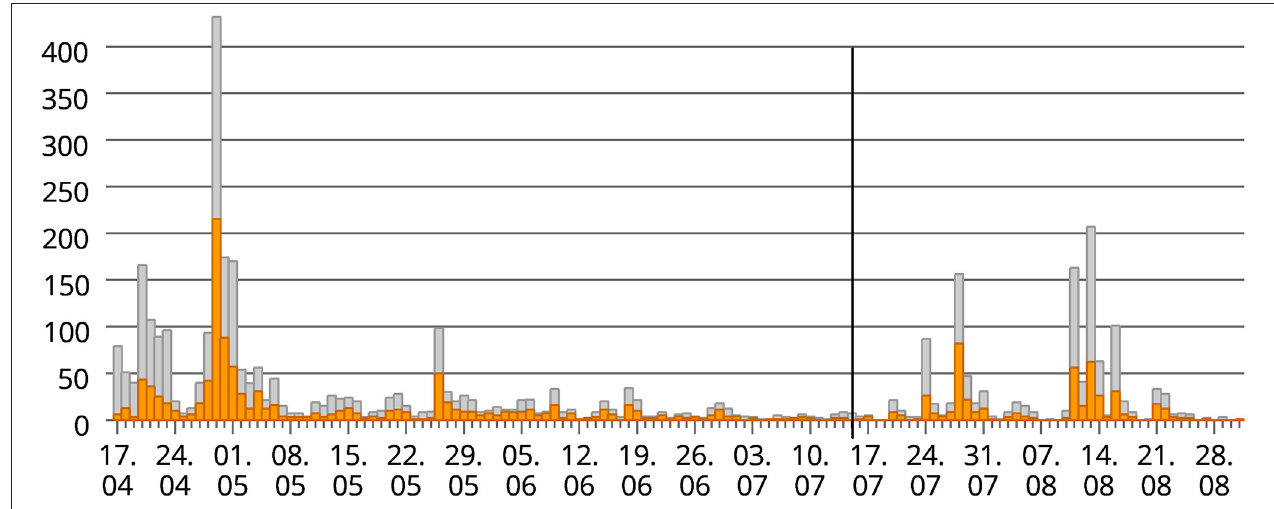
FIGURE 1 | Response pattern of the data collection over time (17.4.-31.8.2020) (x-axis, date of data collection; y-axis, number of responses; orange, completed questionnaires; grey, total responses but incomplete or klicks; black vertical line, end of data collection for this